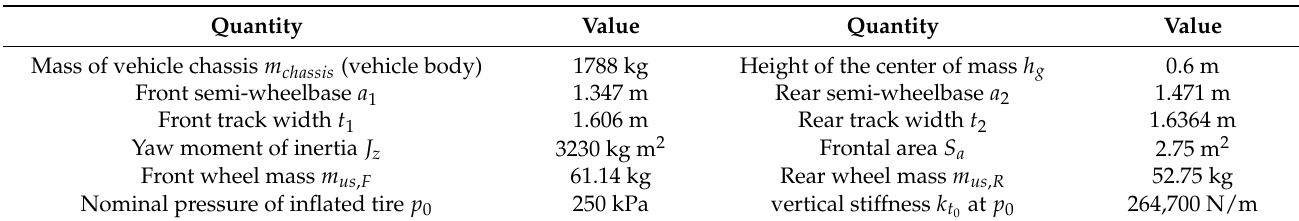
Table 1. Segment-D SUV vehicle parameters.